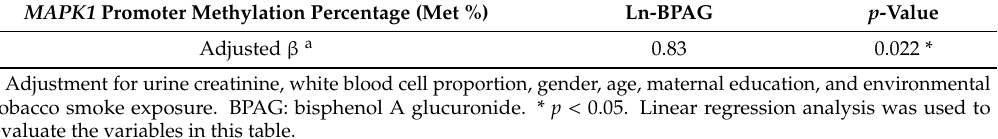
Table 4. The association between the log-transformed BPAG level and standardized regression coe ffi cient β eta for the MAPK1 promoter methylation percentage ( N = 228). MAPK1 Promoter Methylation Percentage (Met %)